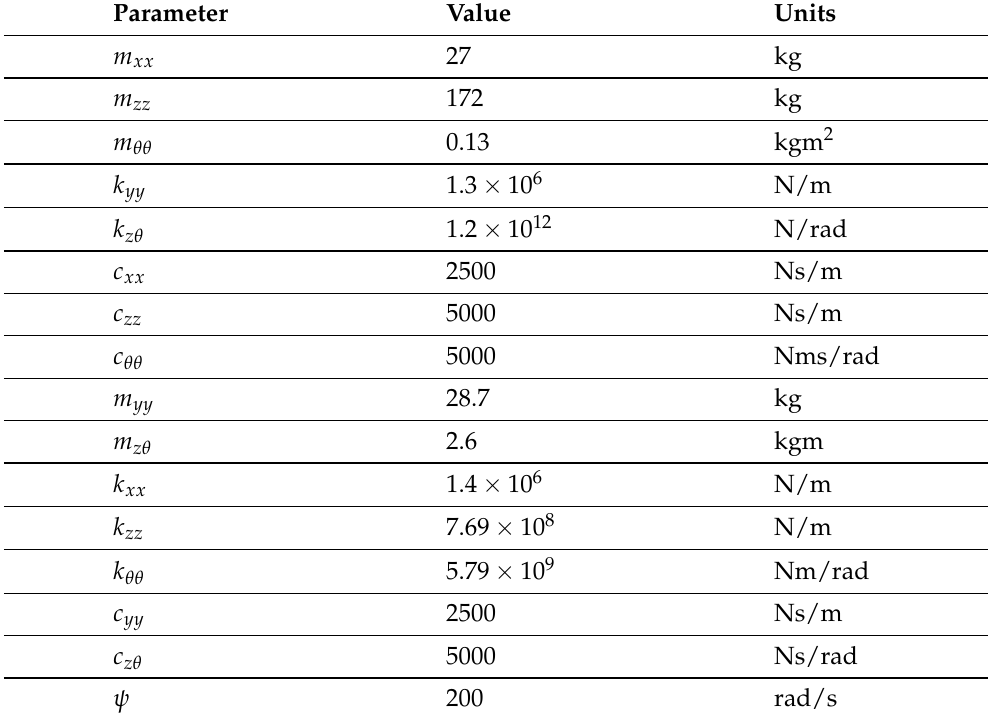
Table 1. Parameters.